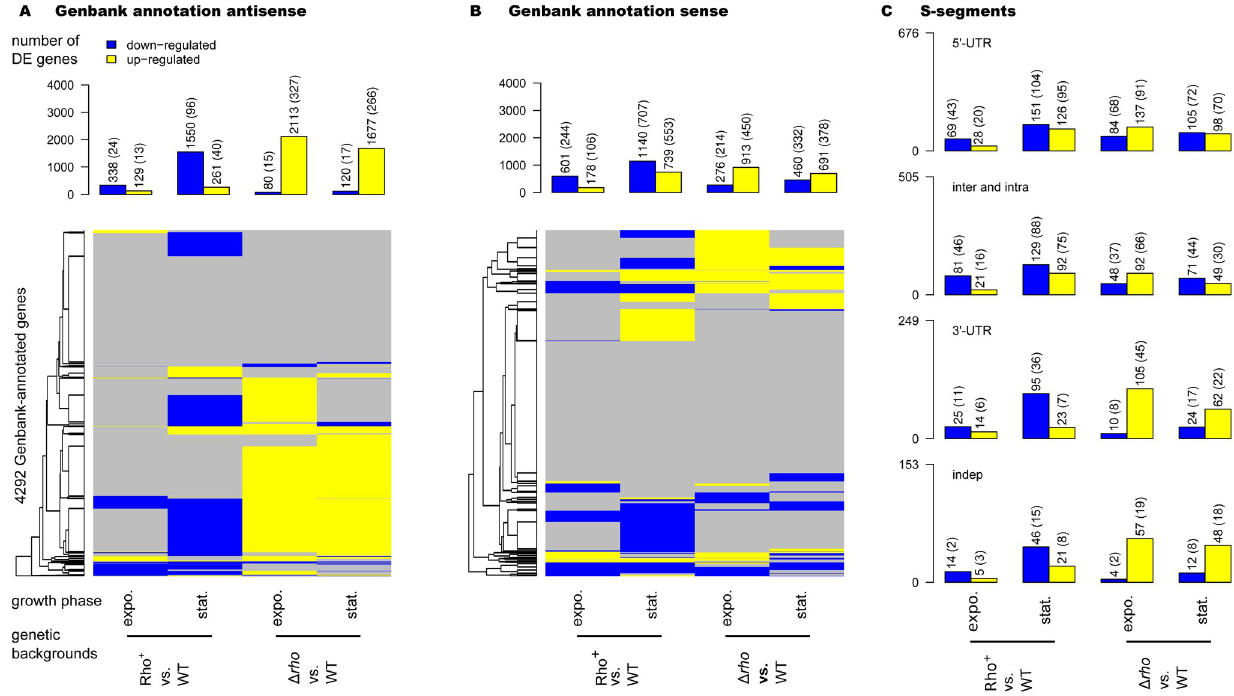
Fig 5. Graphical summary of differential sense and antisense expression (DE) in Rho + and Δ rho across strands and growth phases. DE compared to WT (q-value � 0.05 and |log2FC| � 1) is shown for the antisense ( A ) and sense ( B ) strands of the 4,292 AL009126.3-annotated genes. Up : Barplot representation of the numbers of DE genes: numbers reported above each bar correspond to the total of DE genes and, in parentheses, to the subset exhibiting a minimal expression of log2(fpkm+5) � 5 in one of the two compared genetic backgrounds. Below : Cluster heatmaps highlighting overlaps between these sets of DE genes: up-regulated genes in yellow, down-regulated genes in blue; all other genes, for which there is no statistical evidence for DE, are in gray. Left-side of each heatmap: average-link hierarchical clustering tree based on pairwise distance between genes (L1-norm after encoding down-regulation and up-regulation as -1 and 1, 0 otherwise). (C ) Barplot representation of the numbers of DE S-segments, which were defined regarding to their locations as described in [15]: 5’- and 3’-UTR (for all 5’- and 3’-untranslated regions, respectively), inter and intra (for regions situated between genes), and indep (for independently transcribed segments). The up-regulated S-segments are in yellow, down-regulated are in blue. The number on the left side indicates the total number of S-segments of each defined category. The numbers reported above each bar correspond to the total of DE S-segments and, in parentheses, to the subset exhibiting a minimal expression of log2(fpkm+5) � 5 in one of the two compared genetic backgrounds.